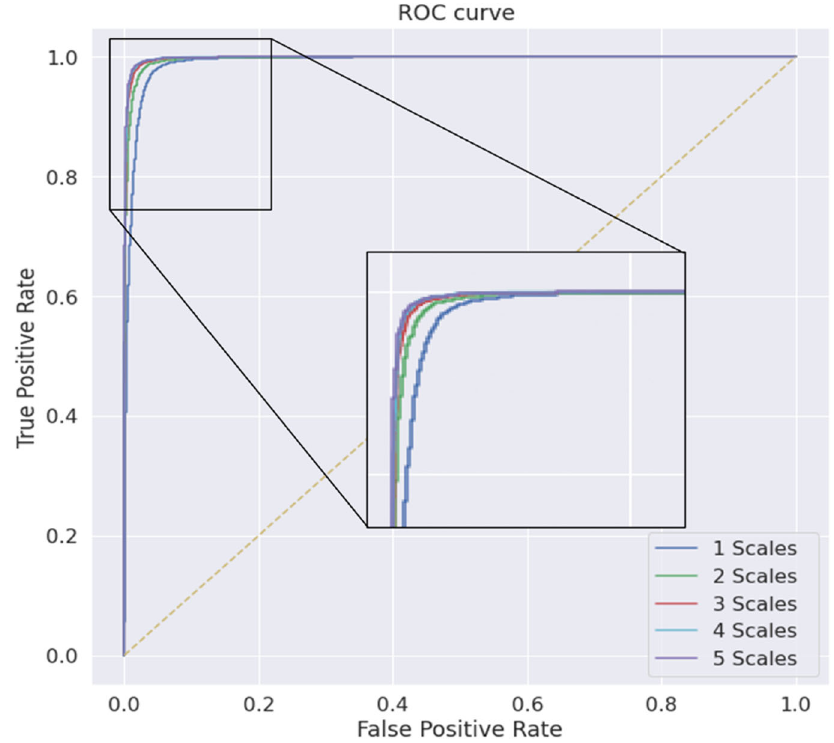
Figure 12. The proposed model’s receiver operating characteristic at different scales and kernel sizes.